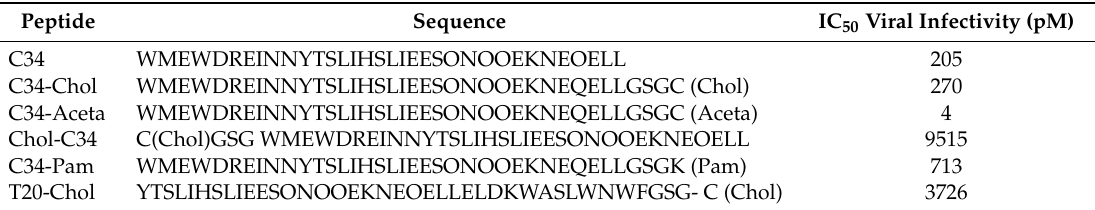
Table 5. Sequence and antiviral potency of C34-Chol and controls against HIV-HXB2. Peptide